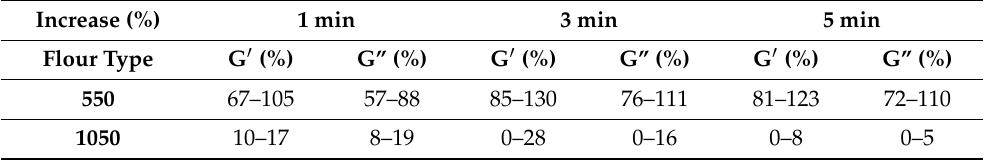
Table 1. Increase in G (cid:48) and G” for the doughs produced with NTP-treated flour samples (presented as minimum-to-maximum increase) in comparison to doughs produced with untreated flour samples) as a function of treatment